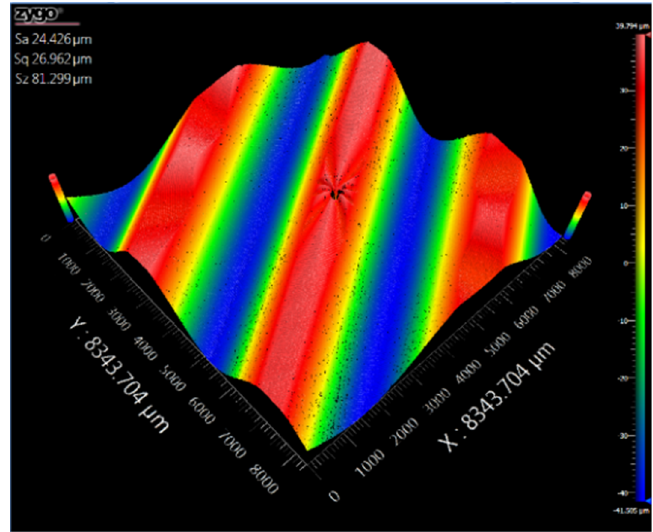
Figure 23. Sinusoidal wavy surface morphology.